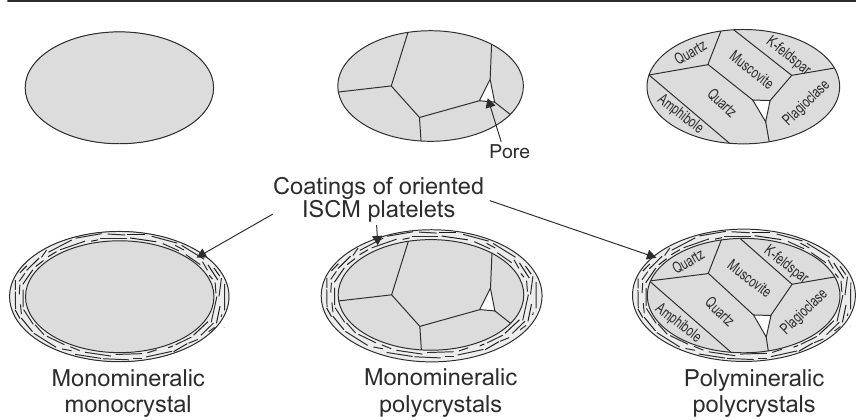
Figure 14. Type-I structural models for single and polycrystals of quartz, plagioclase, K-feldspar, and calcite with clear or clay-coated surfaces. Clay minerals are dominated by